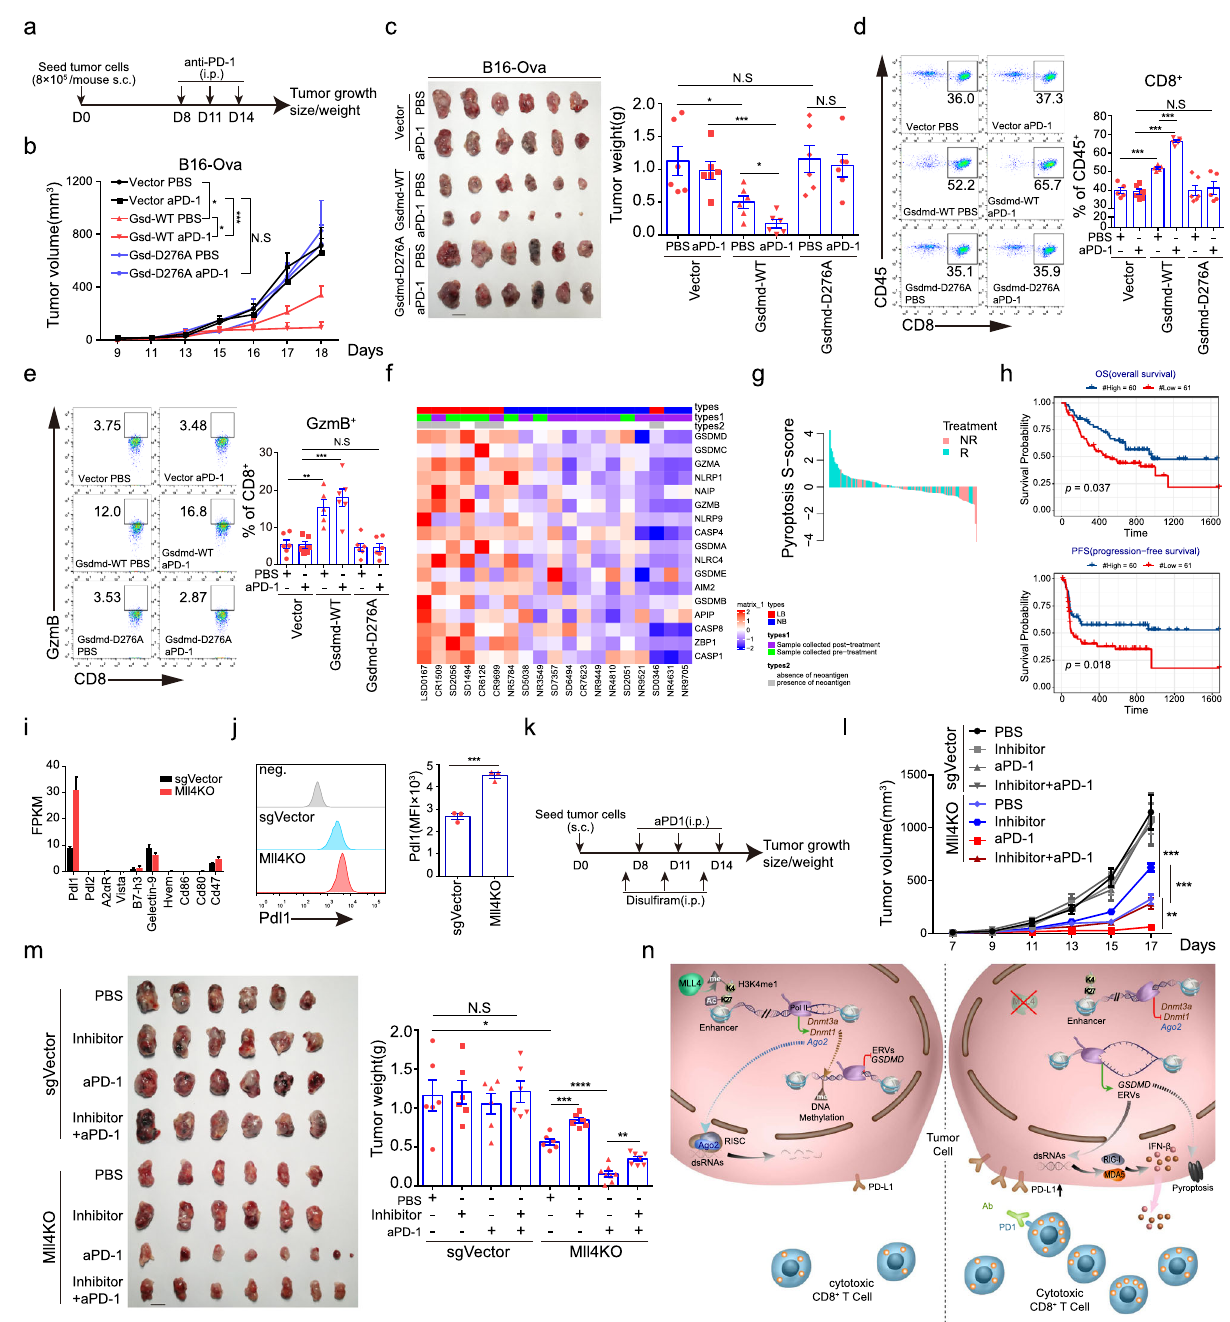
Fig. 7 | Blocking GSDMD-mediated tumor-cell pyroptosis abrogates immu- notherapeutic ef fi cacy of anti-PD-1 blockade in Mll4 − / − tumors. a Experimental schedule for anti-PD-1 treatment in C57BL/6J mice. b Tumor growth curve in mice described in ( a ) (mean±SEM, n =6). c Tumor images and weight quanti fi cation at the time of experimental endpoint in mice described in ( a ) (mean±SEM, n =6). d , e Frequency( d ) and cytotoxicity ofCD8 + T cells( e ) in tumorsofmicedescribed in ( a ) (mean±SEM, n =6 for all groups except for Gsdmd-WT treated with PBS, in which n equals 5_). f Heatmap showing expression of pyroptosis-related genes in tumors from anti-CTLA4 treated metastatic melanoma patients who achieve long- term (LB, complete and partial response or progression-free survival over 6 months) or no bene fi t (NB, progressive disease) 66 . g A waterfall plot showing the pyroptosis S-score in tumors from metastatic melanoma patients who respond or do not respond to anti-PD-1 immunotherapy 68 . h Kaplan – Meier curves showing overall and progression-free survival of melanoma patients splitted by pyroptosis